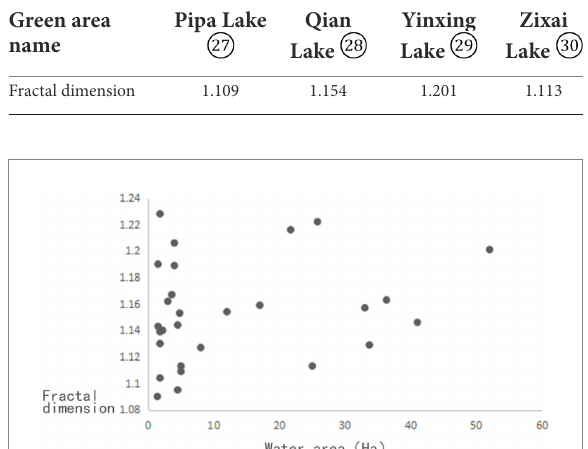
FIGURE 6 Scatter plot of the area of the water body and the fractional dimensional